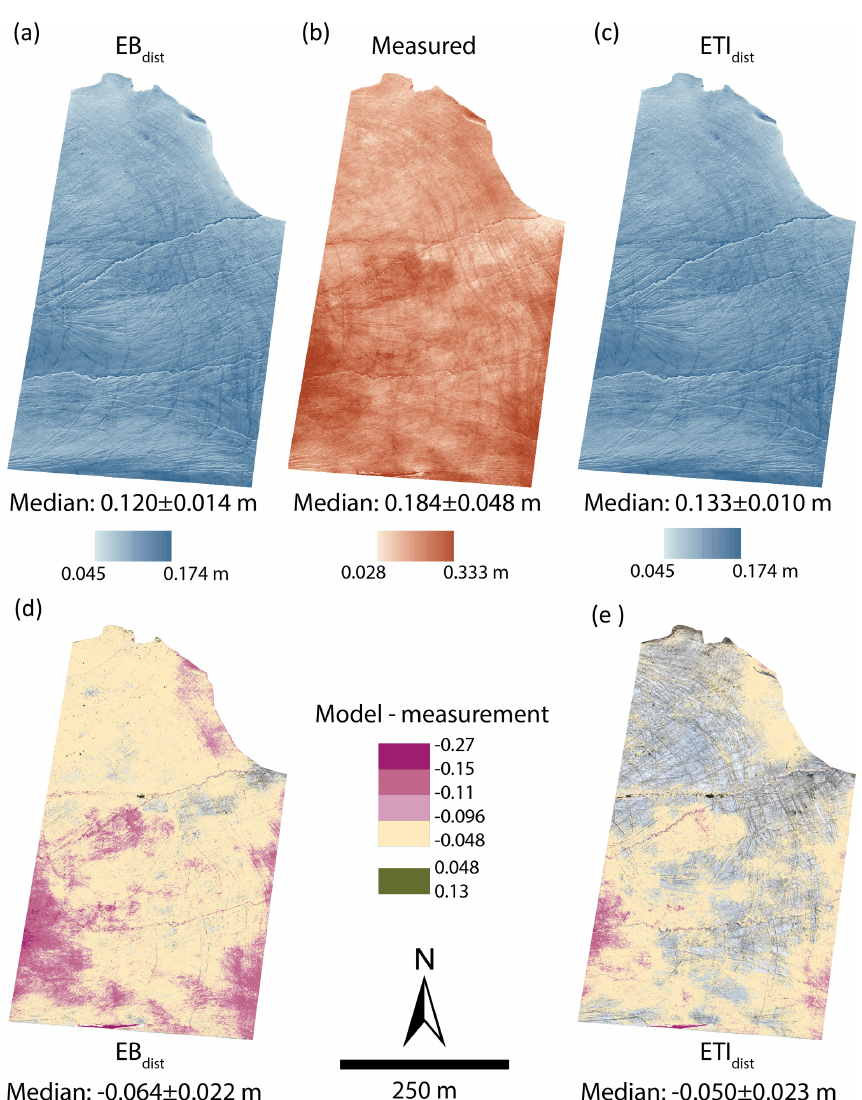
Figure 5. Distribution of measured and modelled melt across the study area between 21 July (12:00LT) and 24 July (12:00LT). (a) Melt estimated using EB dist applied across the study area. (b) Melt measured through differencing surfaces reconstructed from UAV imagery. (c) Melt estimated using ETI dist applied across the study area. (d, e) Model error, calculated by the difference between modelled and measured melt. Cells with an absolute value lower than the measurement uncertainty (0.048m) are transparent to emphasise areas where the model residuals are